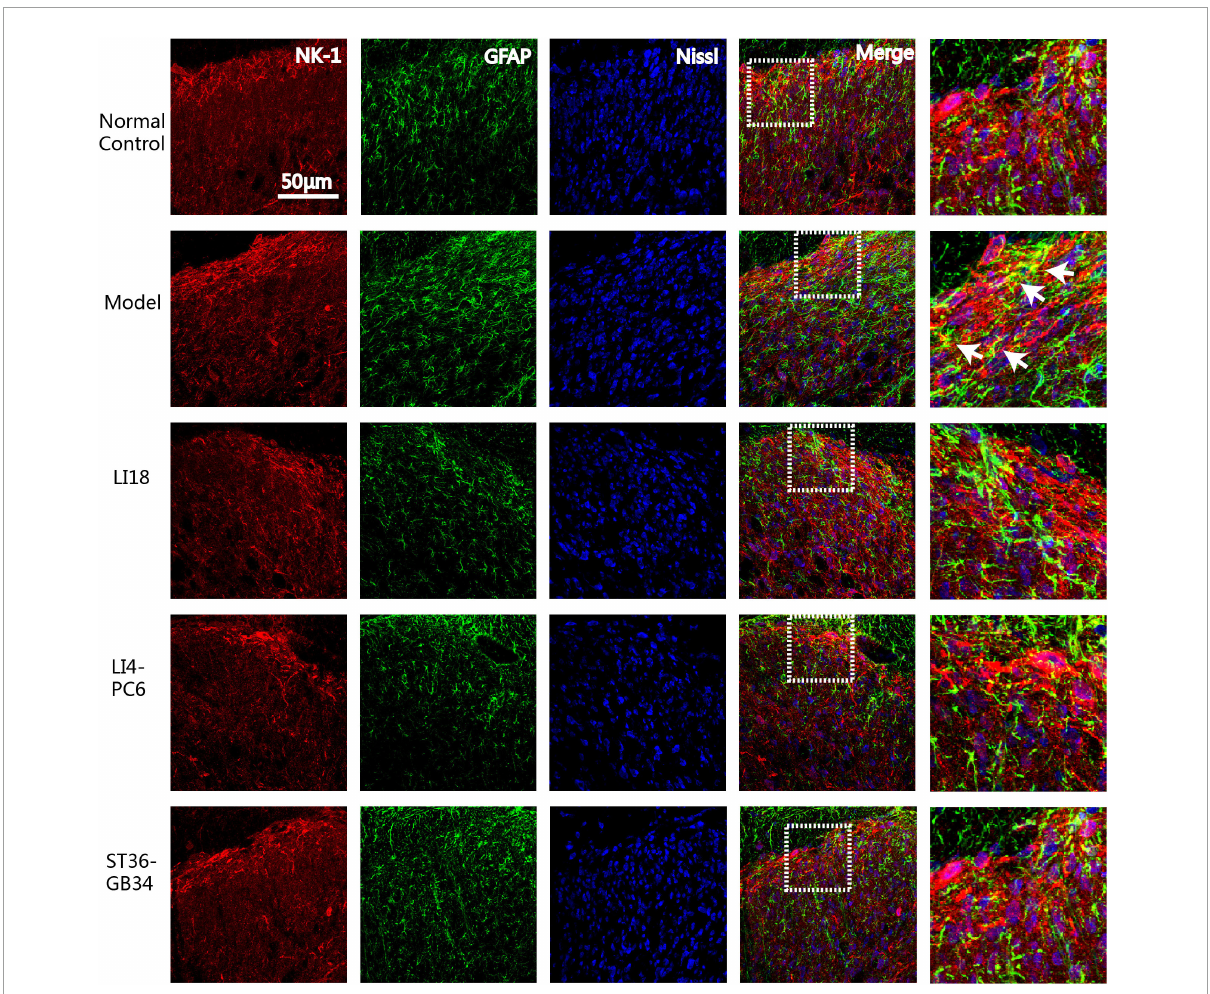
FIGURE6 Confocal micrographs showing the co-expression (yellow) of NK-1 (red) and glial fibrillary acidic protein (GFAP) (green) in dorsal horns (DHs) of the cervical spinal cord in different groups at 24 h after neck incision. The scale bar is 50 µ m. The white arrows indicate the NK-1R positive astrocytes. The expression of NK-1 immunoreaction (IR) and GFAP IR and co-expression were clearly seen in the superficial layer of spinal DHs (laminae II–III) in the model group and reduced in the three EA